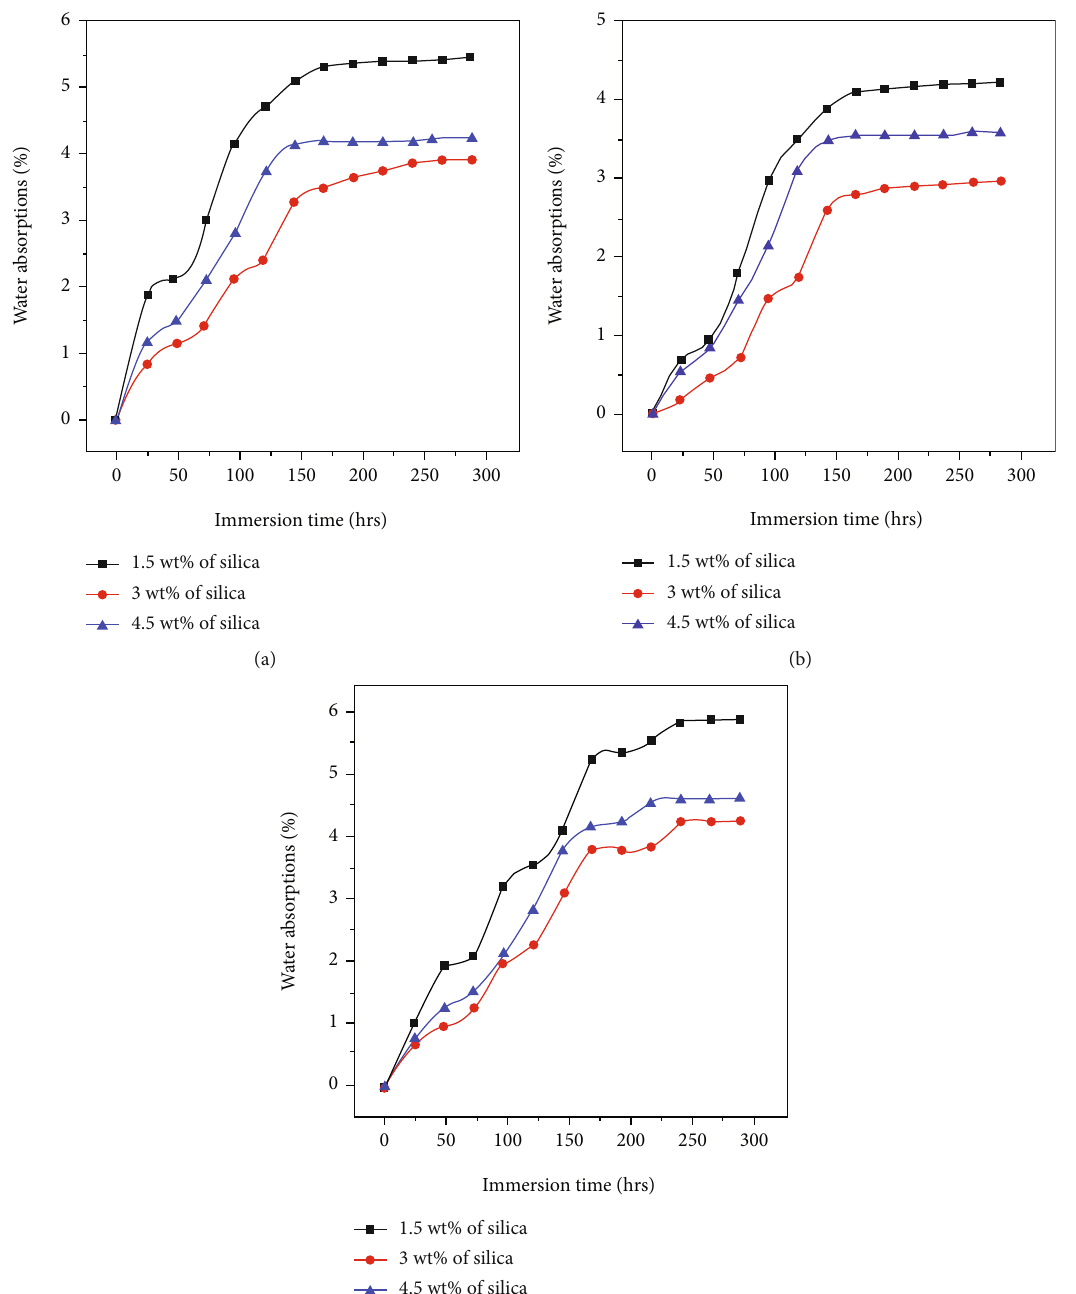
Figure 11: Water retention behaviour: (a) 2hrs NaOCl, (b) 4hrs NaOCl, and (c) 6hrs NaOCl